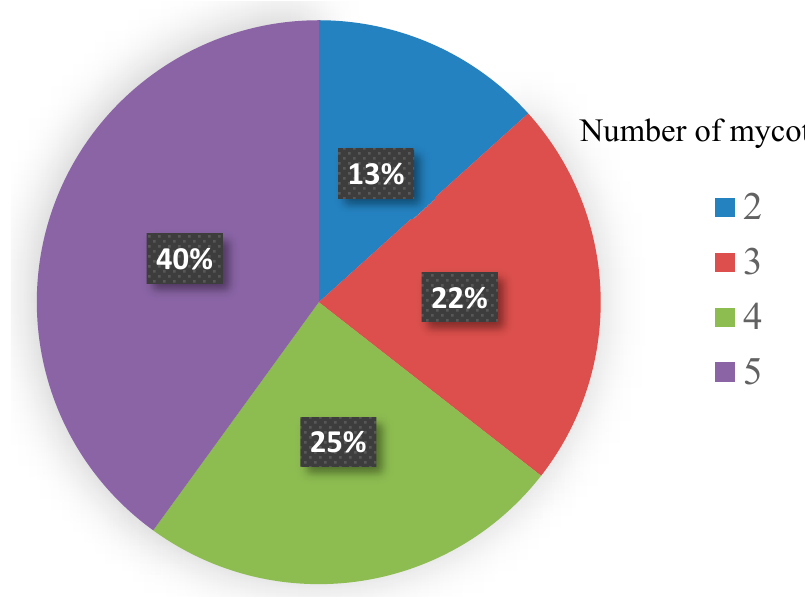
Figure 1. Frequency of maize samples containing two, three, four or five mycotoxins ( n = 45). The co-occurrence of various combinations of mycotoxins found in the analyzed maize samples are presented in Figure 2. Overall, 12 different combinations were observed. All the samples contained at least two mycotoxins while at least three or more mycotoxins were found in 87% of the samples. The most common binary combination was DON+AF, which occurred in 2 samples alone but these toxins also co-occurred in another 7